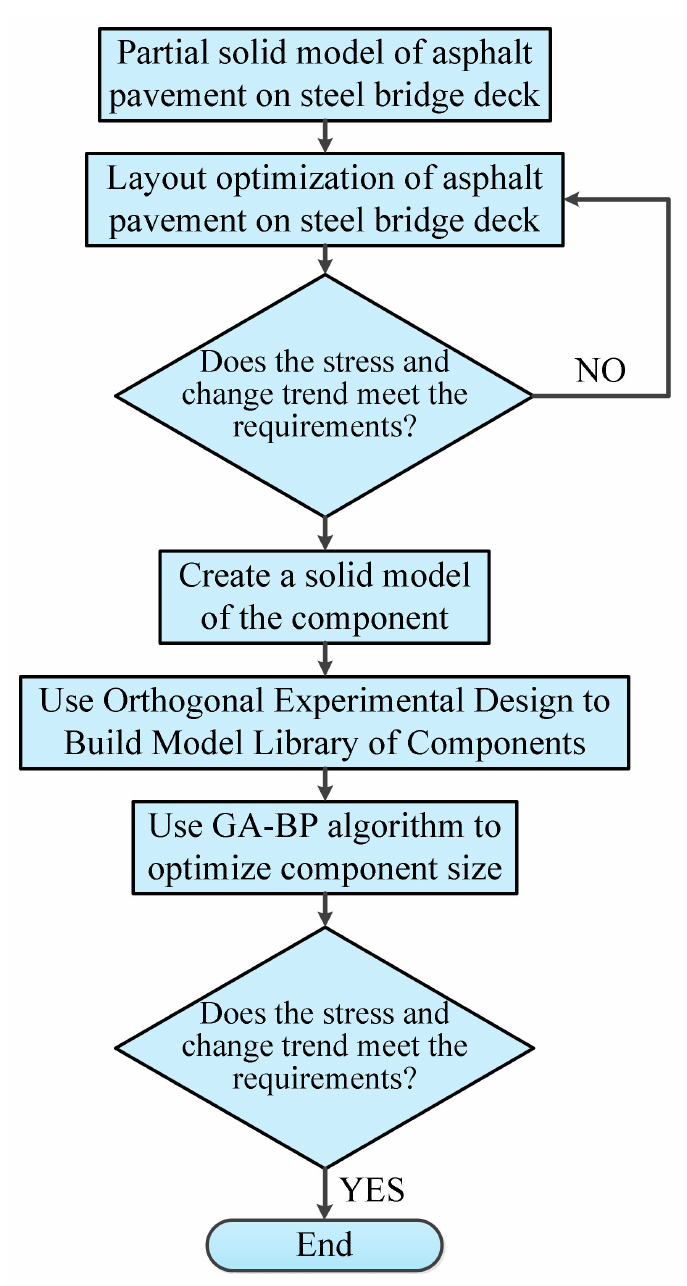
Figure 3. Optimal design flow of asphalt pavement structure on the steel bridge